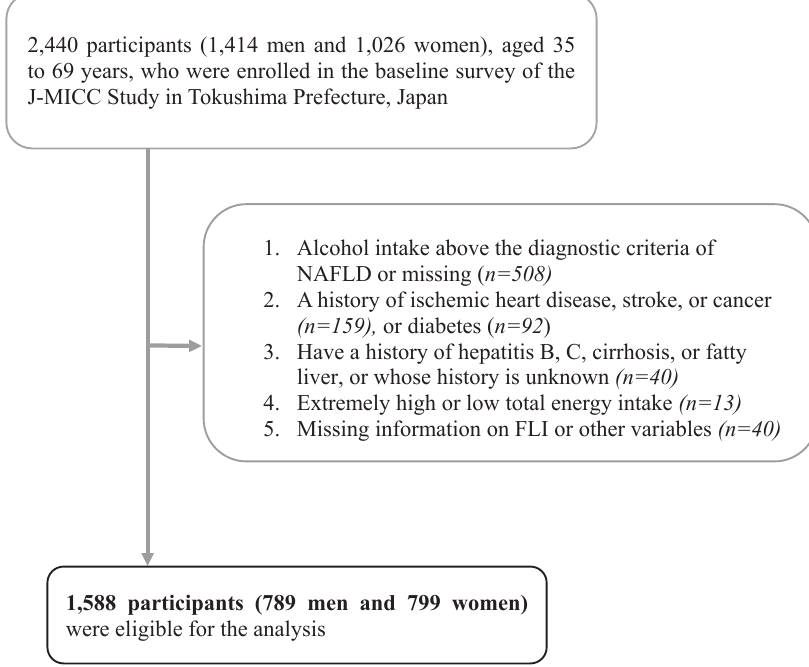
Figure 1. A fl owchart showing the process of selecting study subjects. J-MICC, Japan Multi-Institutional Collaborative Cohort; NAFLD, non-alcoholic fatty liver